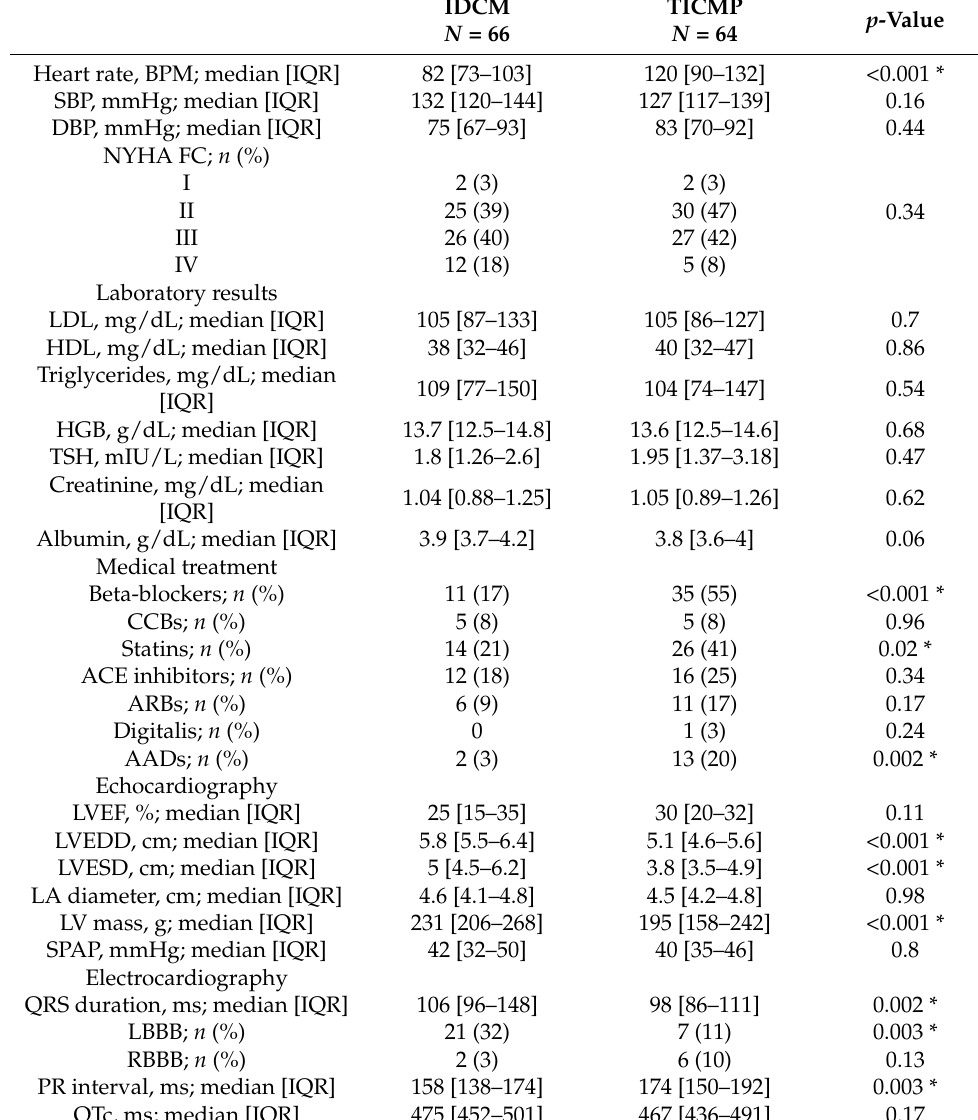
Table 2. Clinical characteristics at